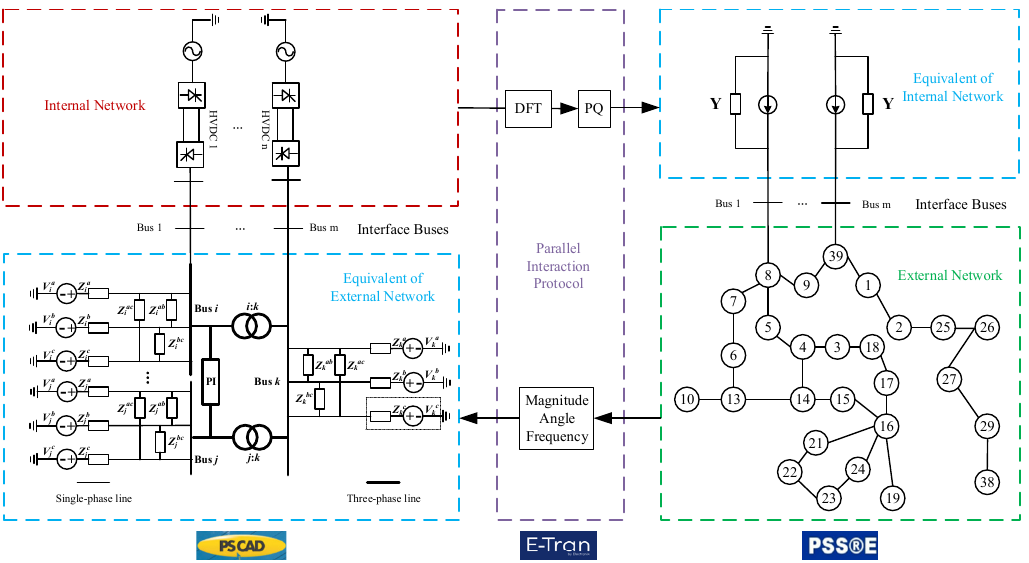
Figure 3. Implementation of the hybrid simulation.